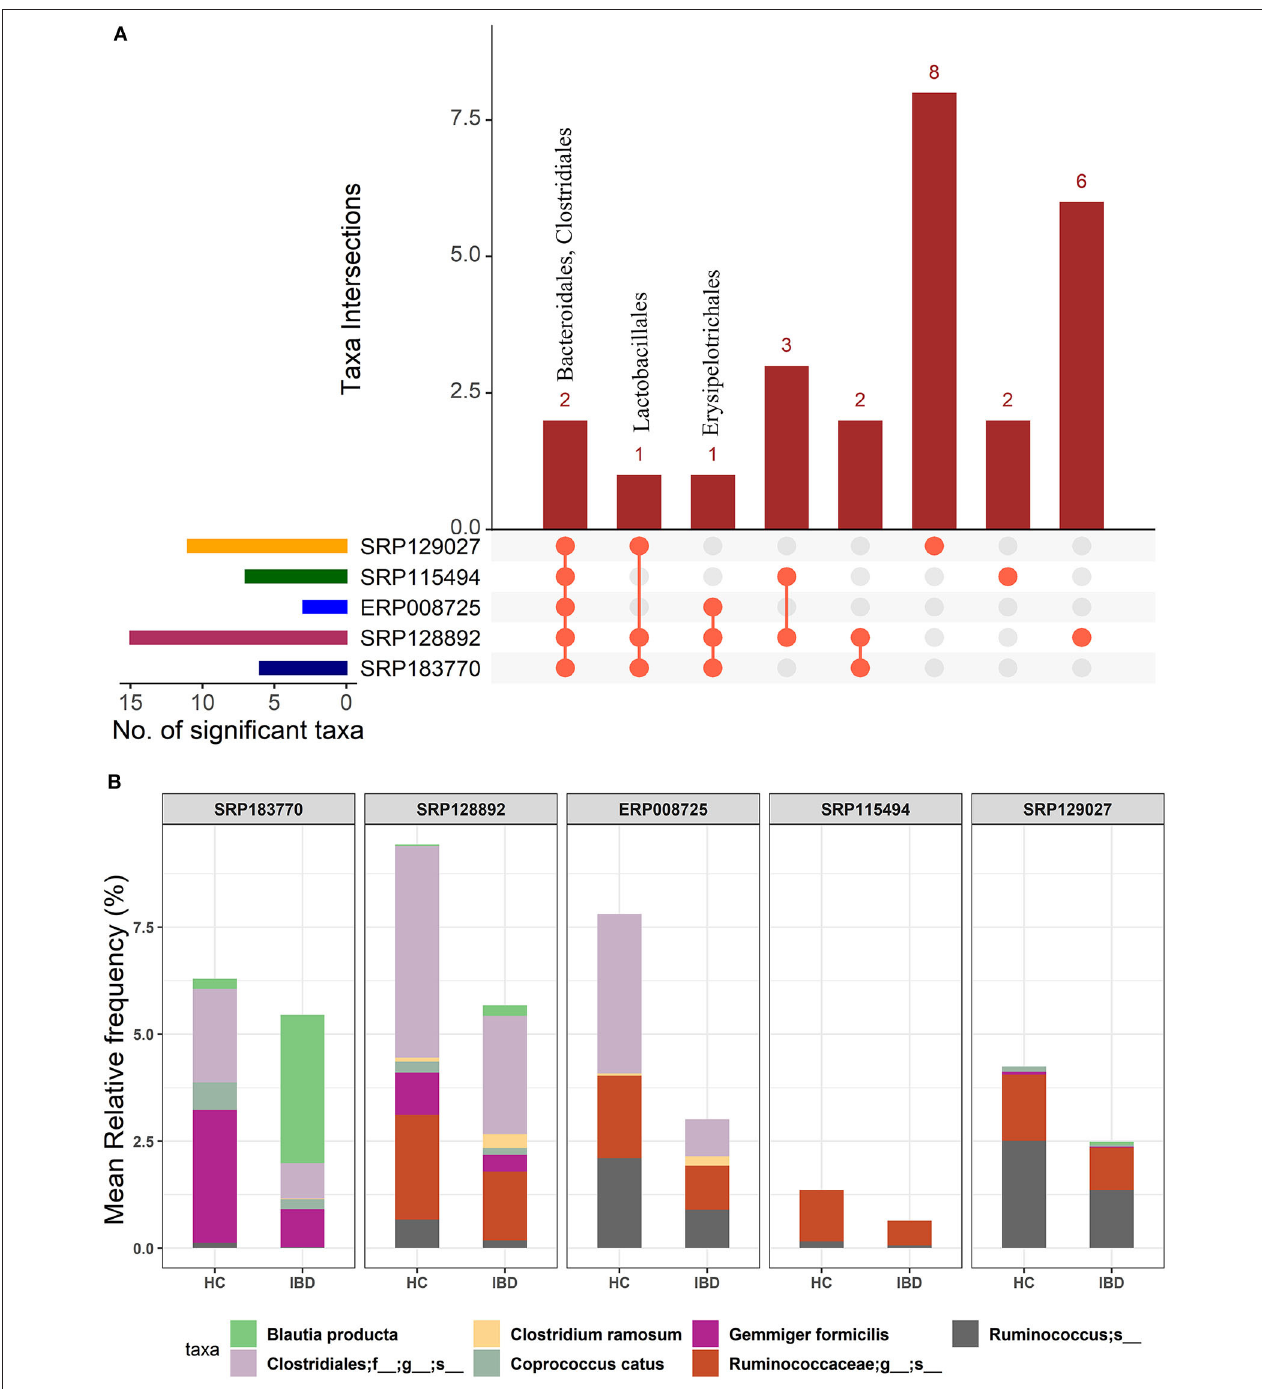
FIGURE 2 | Comparison of microbial communities between IBD and HC cohorts across five different datasets. (A) An upset plot showing taxonomic intersections across the five datasets at the Order-level. Each bar represents the number of orders in that category and the orange dot below the bar indicates their conservation across the datasets. For instance, members of Bacteriodales and Clostridiales are conserved in all five datasets; (B) Stacked bar plots show the relative mean frequencies of significant species-level communities in IBD or HC that are present in at least in three out of five datasets. Corresponding values are provided in the 146 OTUs sheet in Supplementary Datasheet 3 , where the columns contain data for five different